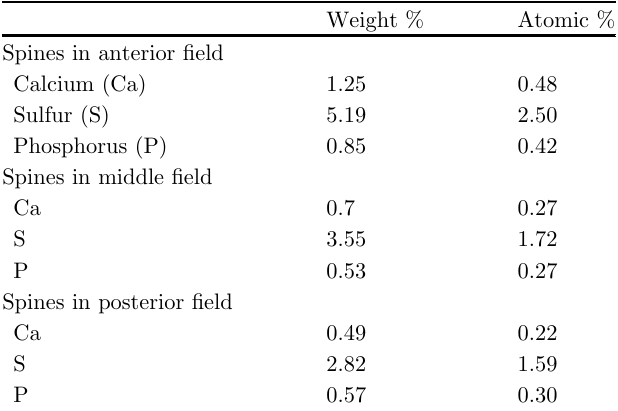
Table 5. Chemical elements (Ca, S, P) detected in cut spines from the anterior, middle and posterior fi elds of the foretrunk of Neoandracantha peruensis . a